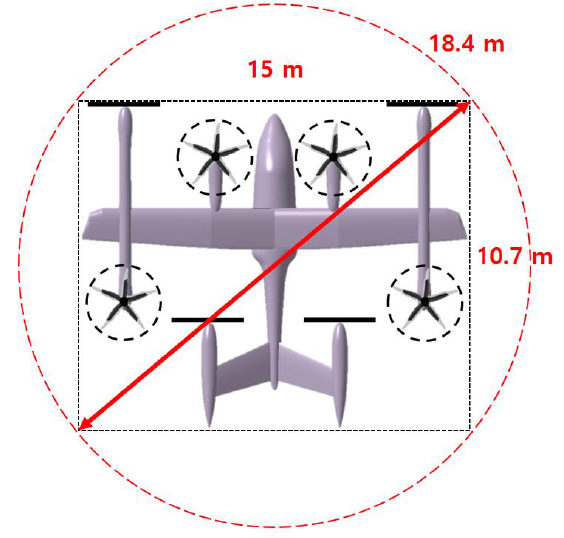
Figure 1. Size of TLOF pad for S-A1.